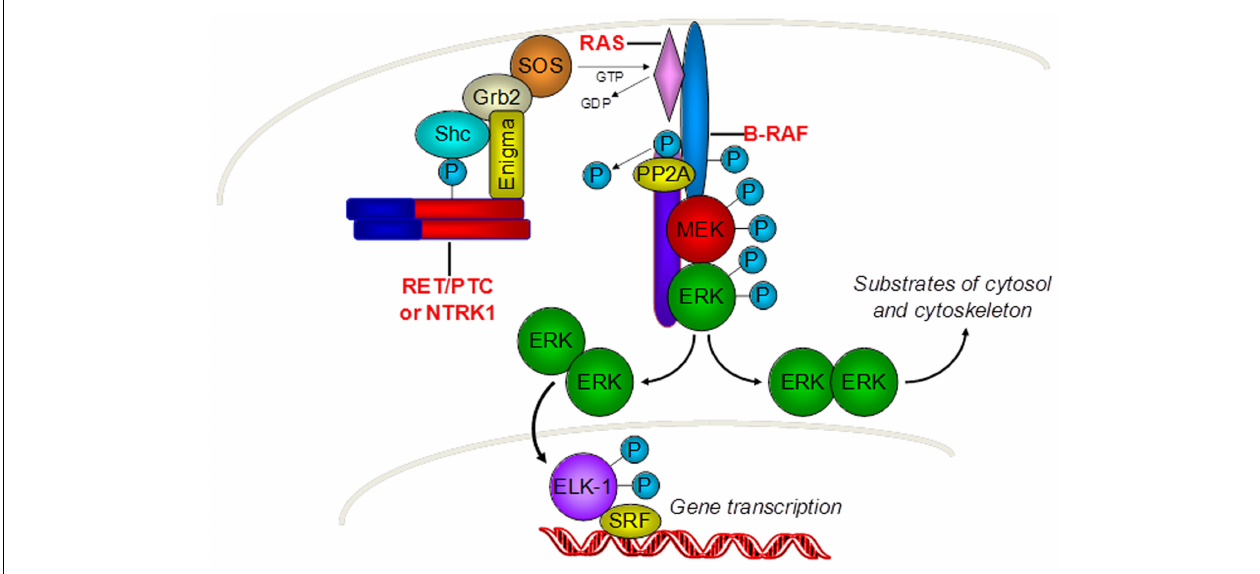
FIGURE 1 | Gene mutations involved in PTC carcinogenesis. PTC is driven by genetic alterations leading to the activation of the mitogen-activated